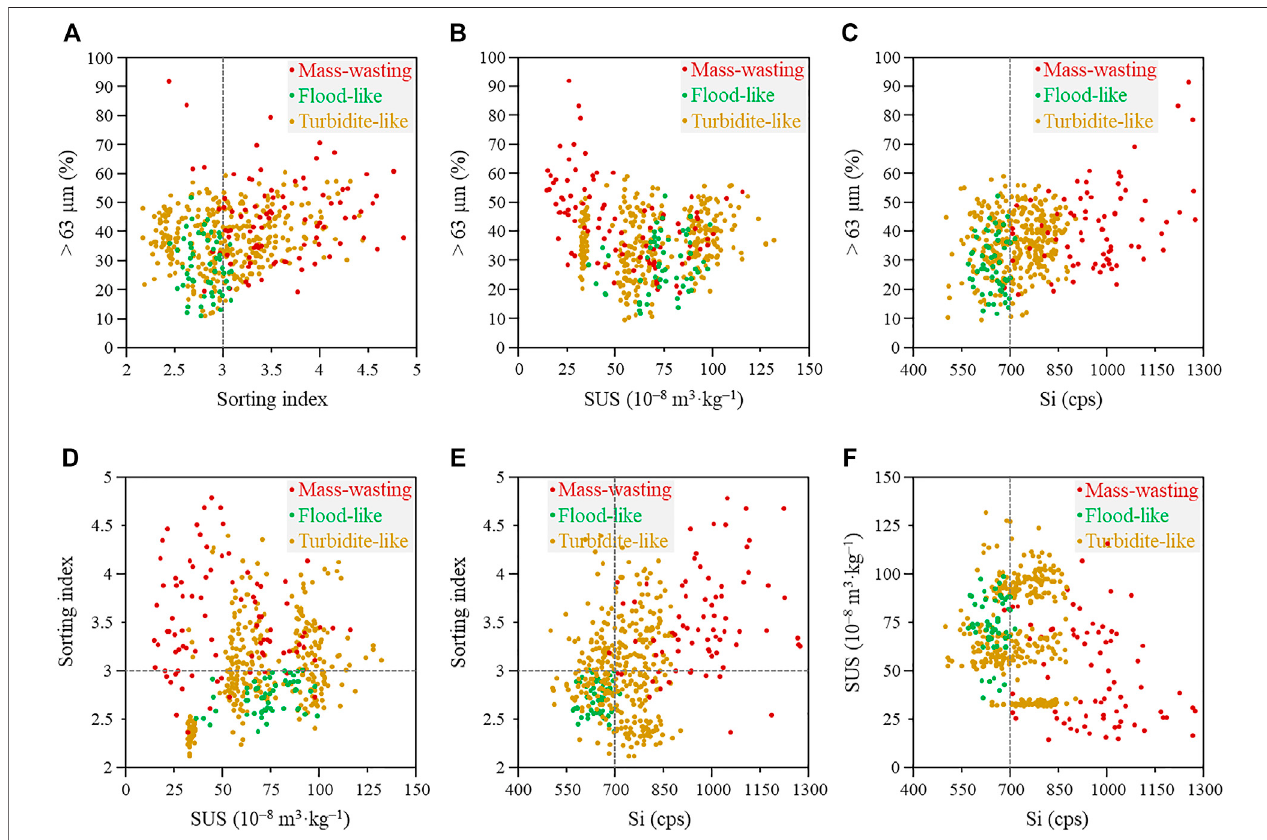
FIGURE 4 | Correlations between (A) percentage of > 63 µm fraction and sorting index, (B) percentage of > 63 µm fraction and SUS, (C) percentage of > 63 µm fraction and Si content, (D) sorting index and SUS, (E) sorting index and Si content, and (F) SUS and Si content of the mass-wasting deposits, fl ood-like deposits and turbidite-like deposits from the Y20B